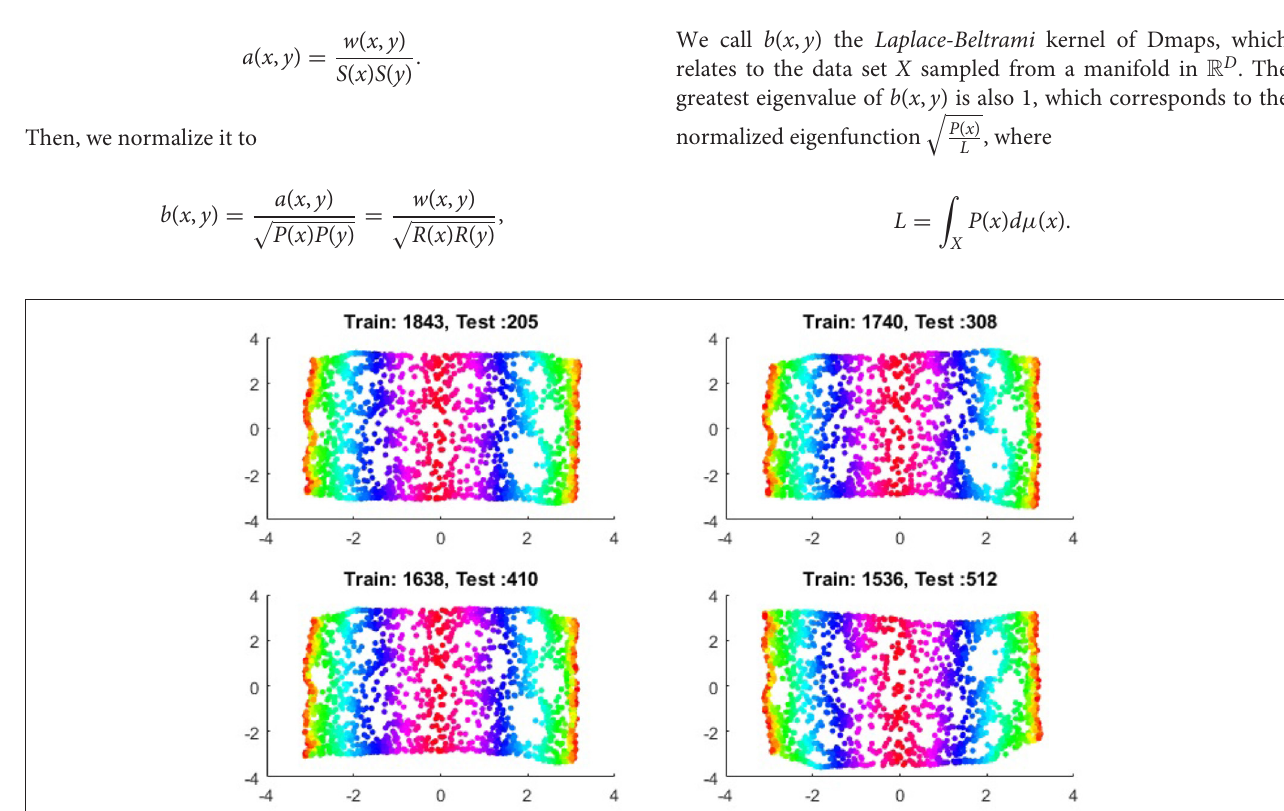
Frontiers in Applied Mathematics and Statistics |